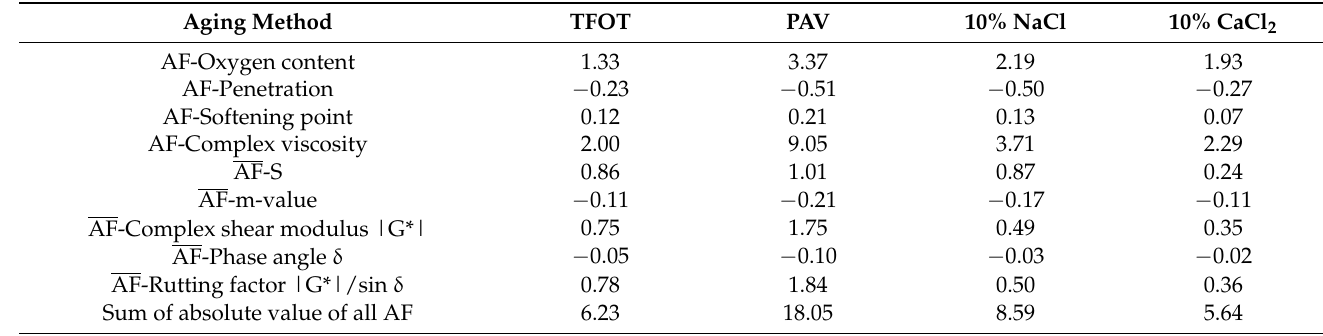
Table 7. The aging factor of four kinds of aging